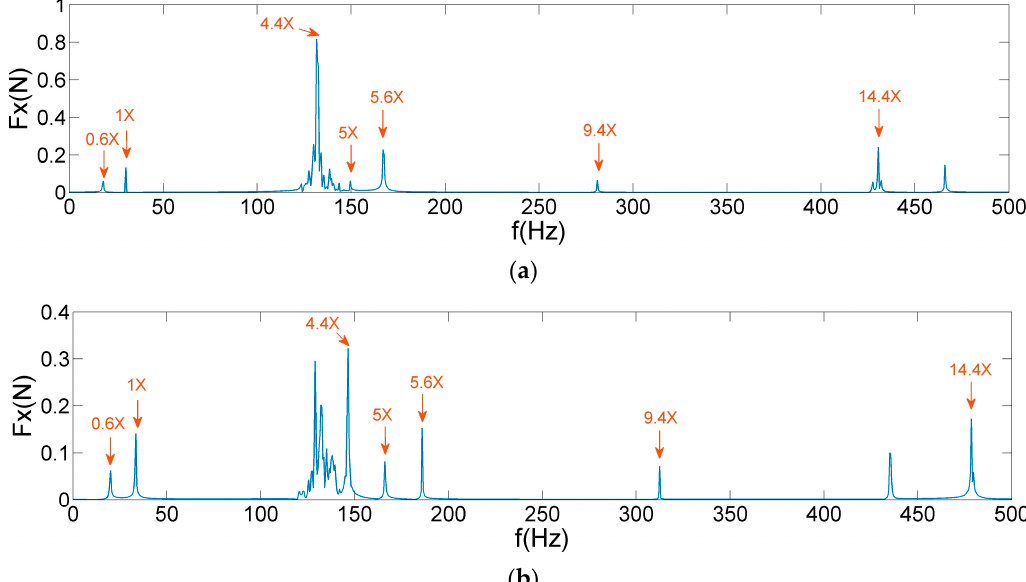
Figure 15. AIC–SVD denoised frequency spectrum of